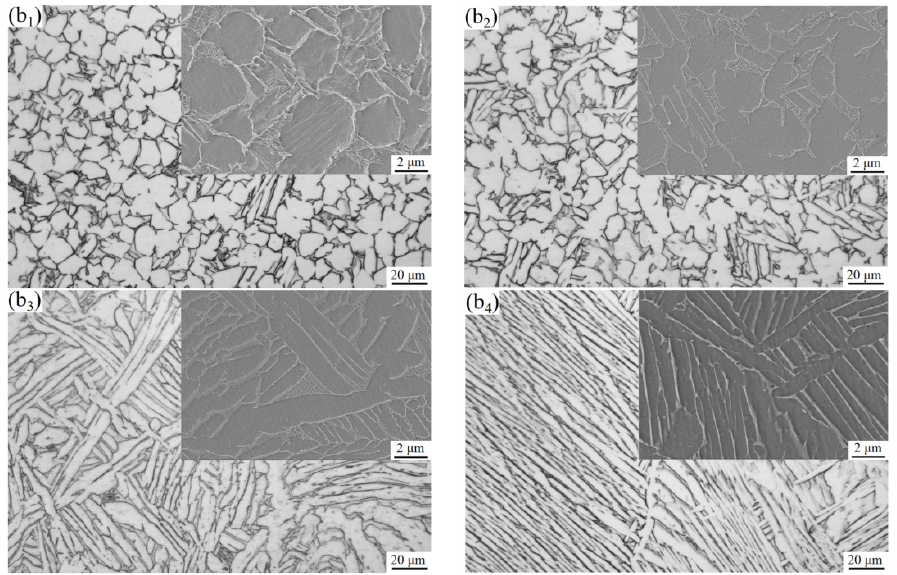
Figure 8. Microstructure after BASCA heat treatment: ( b 1 ) 900 °C; ( b 2 ) 920 °C; ( b 3 ) 940 °C; ( b 4 ) 960 °C.